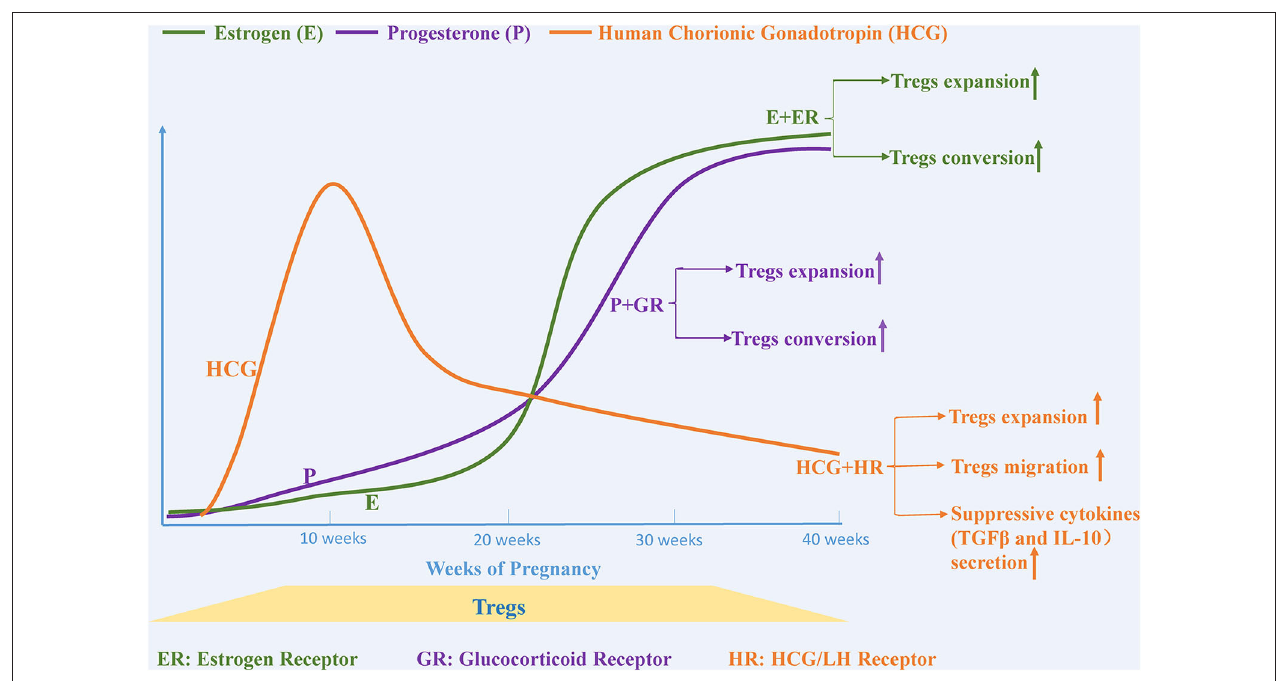
FIGURE 2 | Pregnancy-related hormones affect the expansion and migration of Tregs. The levels of various steroid hormones, such as estrogen, progesterone and human chorionic gonadotropin, change dramatically during pregnancy. Estrogen and progesterone promote Tregs expansion and trigger the conversion of CD4 + CD25– T cells to Tregs separately by binding to estrogen and glucocorticoid receptors. The level of human chorionic gonadotropin (HCG), another essential hormone for maintaining a healthy pregnancy, begins to increase after fertilization, peaks at the 11th week, and then gradually decreases until birth. HCG functions as a regulator that not only upregulates the expansion of Tregs but also provokes migration of Tregs from the circulation to the